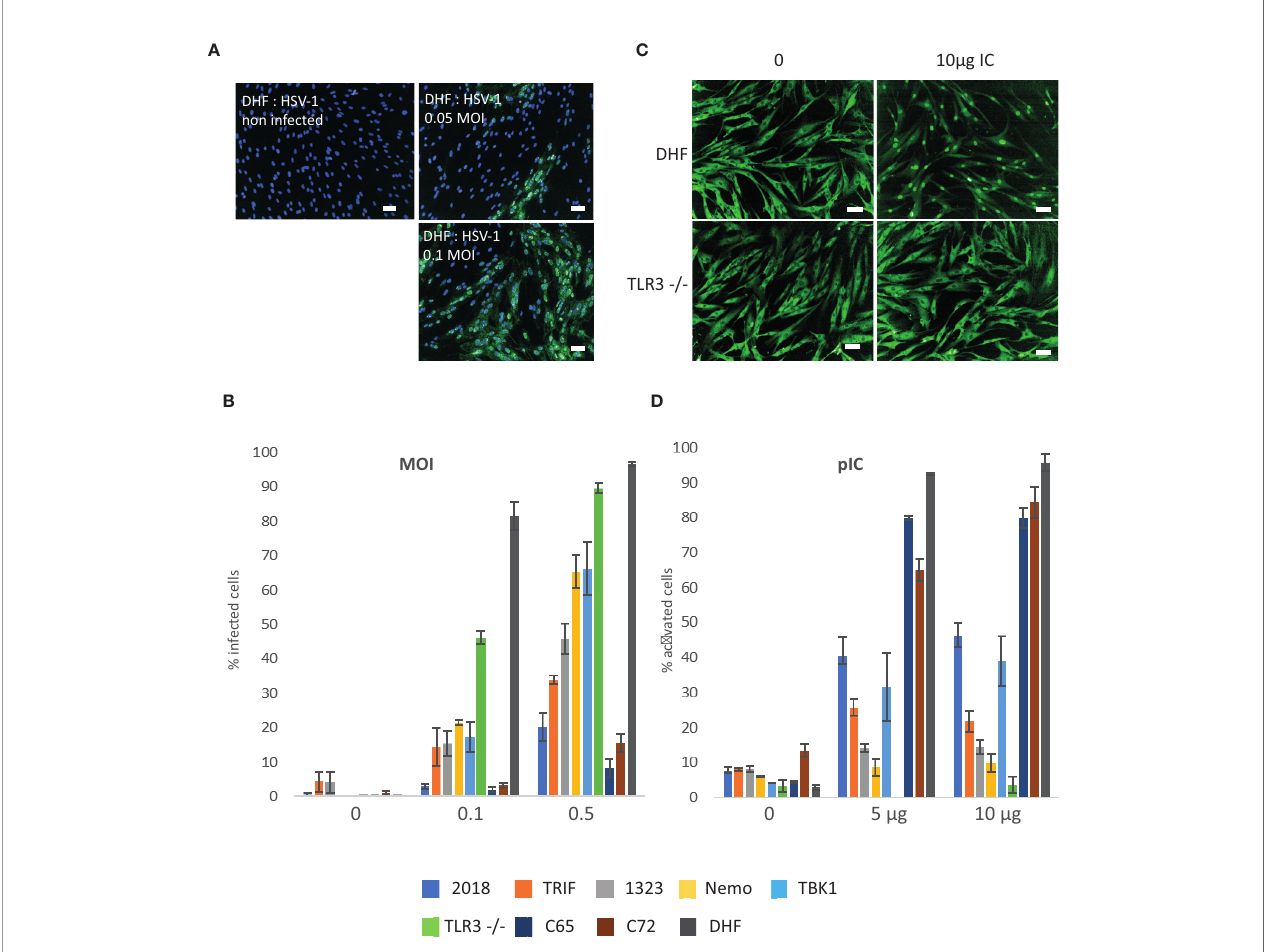
FIGURE 1 | HSV1- green fl uorescent protein (GFP) infection and response to Poly (I:C) stimulation of healthy and mutant fi broblasts. (A, B) HSV1-GFP infection of healthy and mutant fi broblasts (A) Overlays of the detection of the fl uorescence signal in DHF cells (green) infected at 05, 0,1 MOI and non-infected controls with a nuclei Hoechst counterstain (blue). Images were acquired on an Opera QEHS system with a 10x objective and correspond to one fi eld of view. Scale bar: 50µm. (B) Quanti fi cation of the percentage of infected cells after infection with 0, 0,1 and 0,5 MOIs. Compiled results of the mean percentages presented together for comparison: 2018 (TLR3 +/- cells), Trif (TRIF-/- cells), 1323 (TLR3 +/- cells), Nemo (NEMO -/- cells), TBK1 (TBK1 -/- cells), TLR3-/- cells, control cells C65 et C72, and DHF. Bars plot the mean ± sd of triplicates of each experimental point. All cell lines are SV40 immortalized fi broblasts except DHF which are primary fi broblasts. (C, D) Poly (I:C) stimulation of healthy and mutant fi broblasts (C) Representative images of the immuno fl uorescence signal of DHF (upper part) and TLR3-/- (lower part) fi broblasts labeled with an anti- NF- k B antibody: non-stimulated cells (left) and stimulated with 10µg Poly (IC). Scale bar: 50µm. (D) Percentage of cells with nuclear NF- k B (activated) for cells stimulated with 1µg and 10µg of Poly (I:C) and control unstimulated cells (0): 2018 (TLR3 +/- cells), Trif (TRIF-/- cells), 1323 (TLR3 +/- cells), Nemo (NEMO -/- cells), TBK1 (TBK1 -/- cells), TLR3-/- cells, control cells c65 et c72, and DHF. Bars plot the mean ± sd of triplicates of each experimental point. All cell lines are SV40 immortalized fi broblasts except DHF which are primary fi